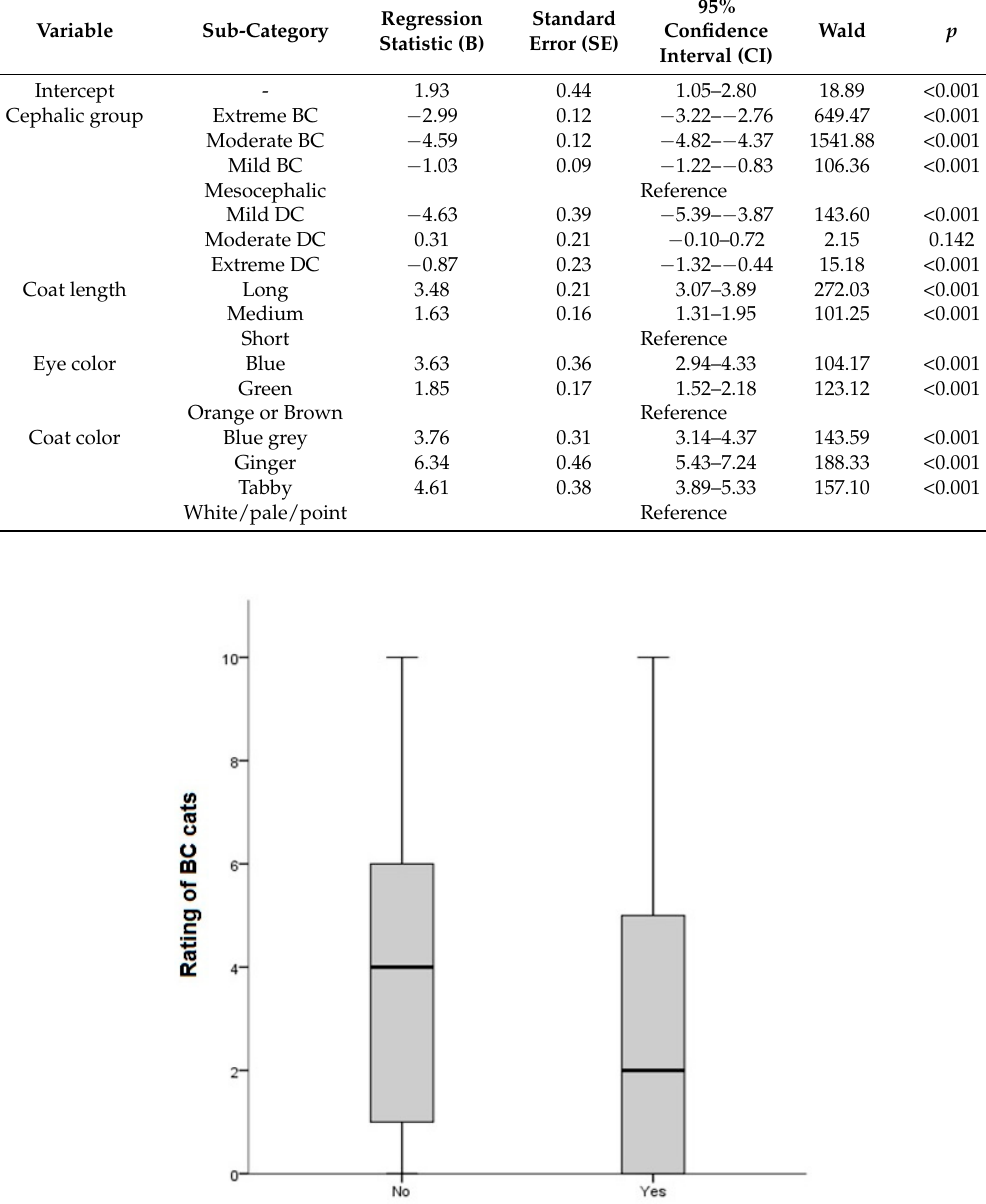
Table 3. Generalized estimating equation of variables that predict respondent’s ( n = 1239) ratings of cat images ( n = 15; as per Table 1) based on physical appearance, taking owner and cat identification into account as random effects. BC = Brachycephaly; DC = Dolichocephaly. “Reference” is the sub-category against which those within the same variable were compared.